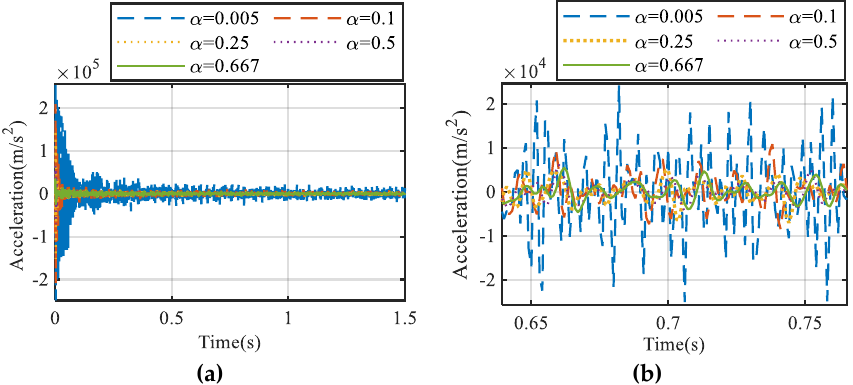
Figure 19. Acceleration responses of Point A for various parameter α : ( a ) acceleration responses from 0 to 1.5 s; ( b ) partial enlarged drawing of responses.